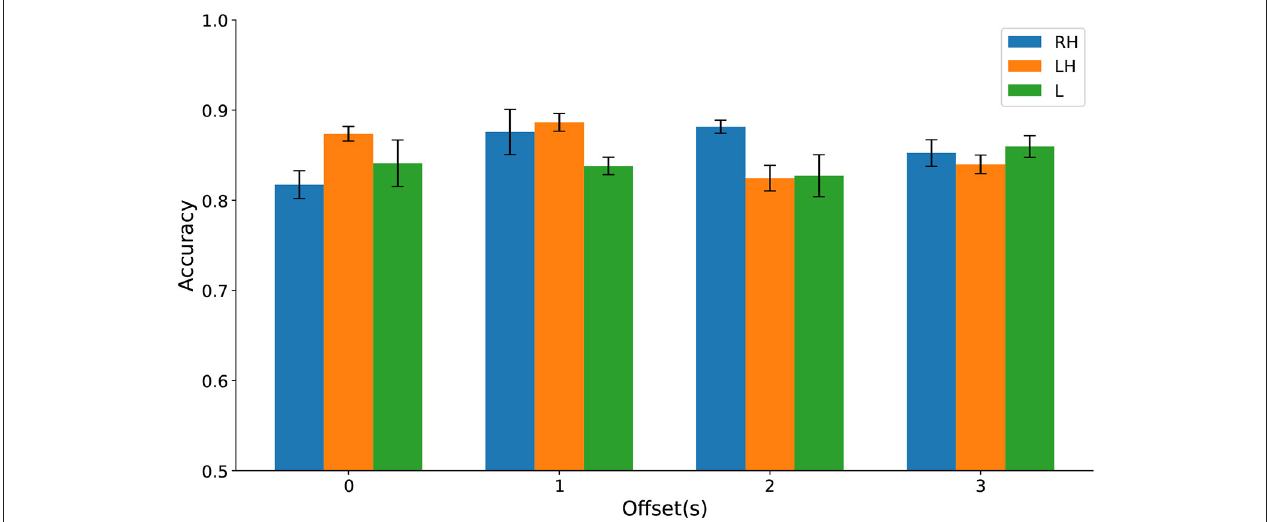
FIGURE 12 | (Dataset 2) Classification accuracy evaluated on sPDP vs. sPNP separately on Right Hand (RH), Left Hand (LH), and Leg (L) data (represented by bars with different colours) varies with temporal window offset (groups along the x-axis).